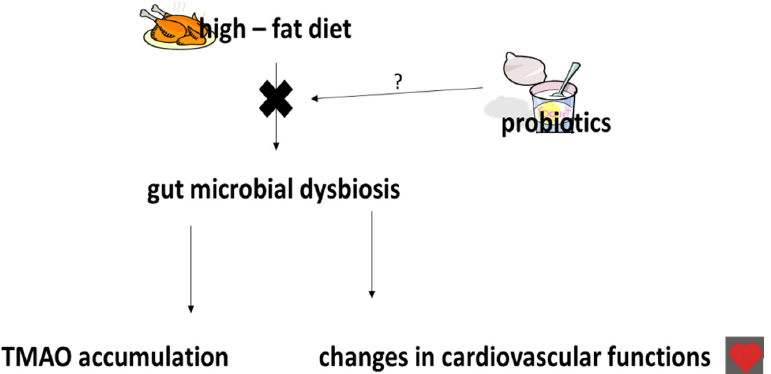
Figure 2. Effect of probiotics on trimethylamine-N-oxide (TMAO) accumulation and changes in cardiovascular functions. More details in text (modified) [70].